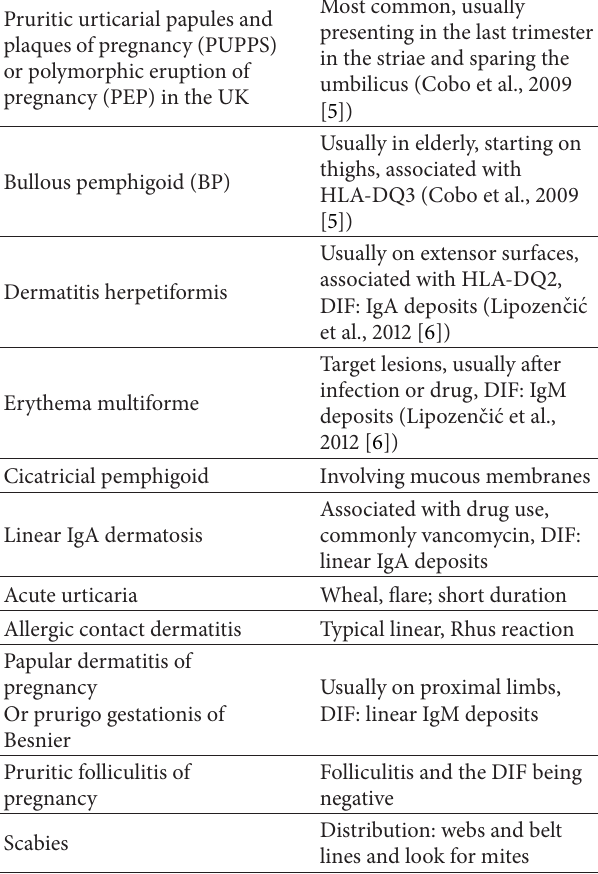
Table 1: Differential diagnosis for a pruritic rash in pregnancy. Pruritic urticarial papules